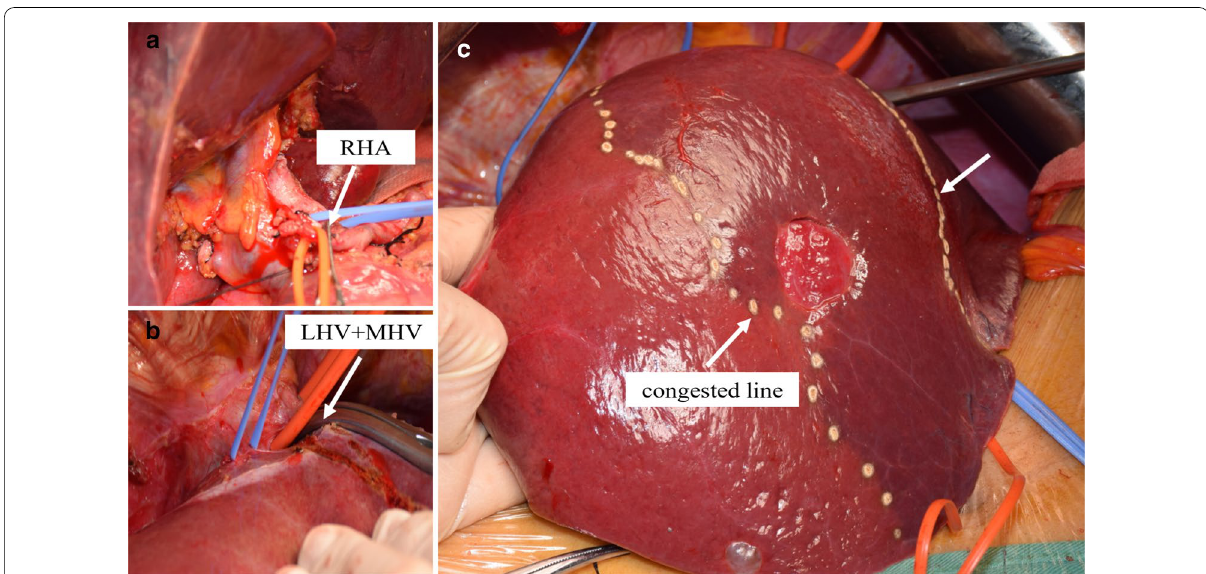
Fig. 12 After blocking the right hepatic artery ( a ) and the middle and left hepatic veins ( b ), the hepatic congested area in segment 5 and segment 8 was revealed ( c ), indicating that this was the region drained by MHV. MHV middle hepatic vein, LHV left hepatic vein, RHA right hepatic